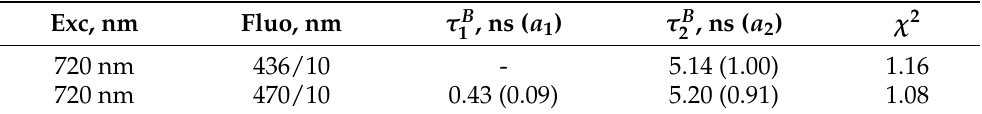
Table 5. Fluorescence decay times τ B double-exponential